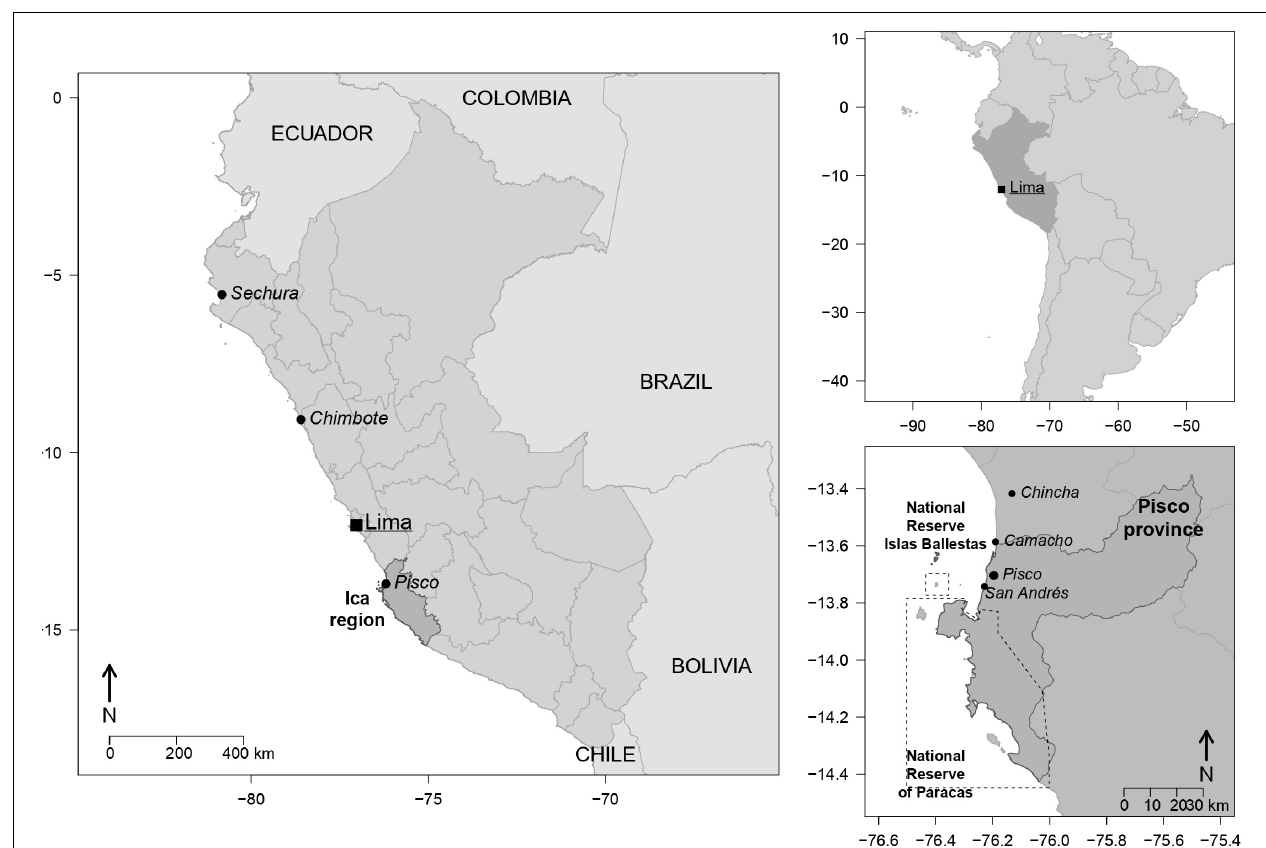
FIGURE 1 | Overview map of Peru, indicating the country’s capital Lima and the region of Ica (panel to the left) ; Peru in the context of the Latin American continent (panel to the upper right) ; the study setting Pisco province, indicating the two National Reserves (dashed line) (panel to the lower right)